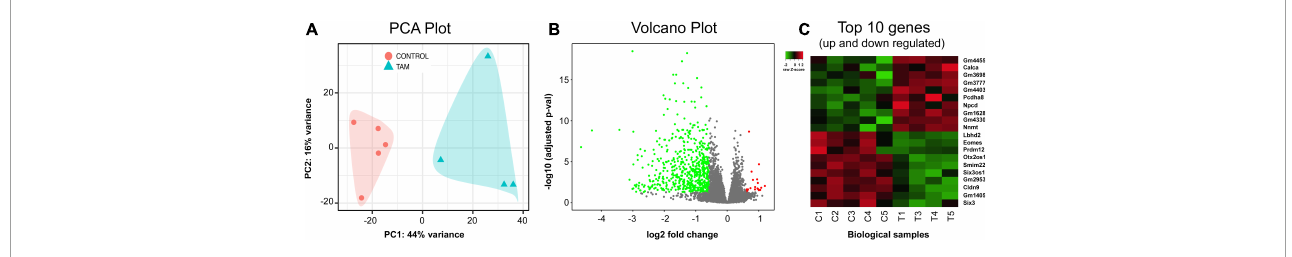
FIGURE7 RNA-seq analysis and transcriptome profile. Hippocampus mRNA differential expressional levels between control ( n = 5) and tamoxifen-treated (TAM) ( n = 4) mice. (A) Principal component analysis (PCA) of all RNA-seq hippocampal samples. Control group (red) and tamoxifen group (blue) are clustering distinctly. (B) Volcano plot analysis summarizing differentially expressed genes (DEGs) of tamoxifen-treated group vs. control group of animals. A total of 669 genes were identified as significant DEGs, out of which 647 (green) genes were found to be down-regulated and 22 (red) genes were up-regulated in TAM treated animals compared to controls. (C) Heat plot summarizing top 20 genes (10 up-regulated and 10 down-regulated) based on lowest adjusted p -value (FDR = 0.05, fold change cut-off = 1.5). Details of these genes are also listed in Table 2 .